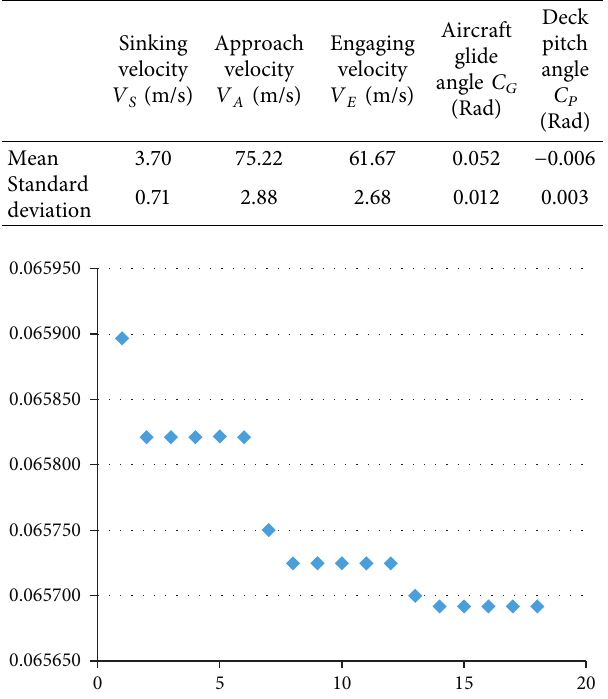
Table 4: The mean and standard deviation of the F/A-18A deck landing parameters.